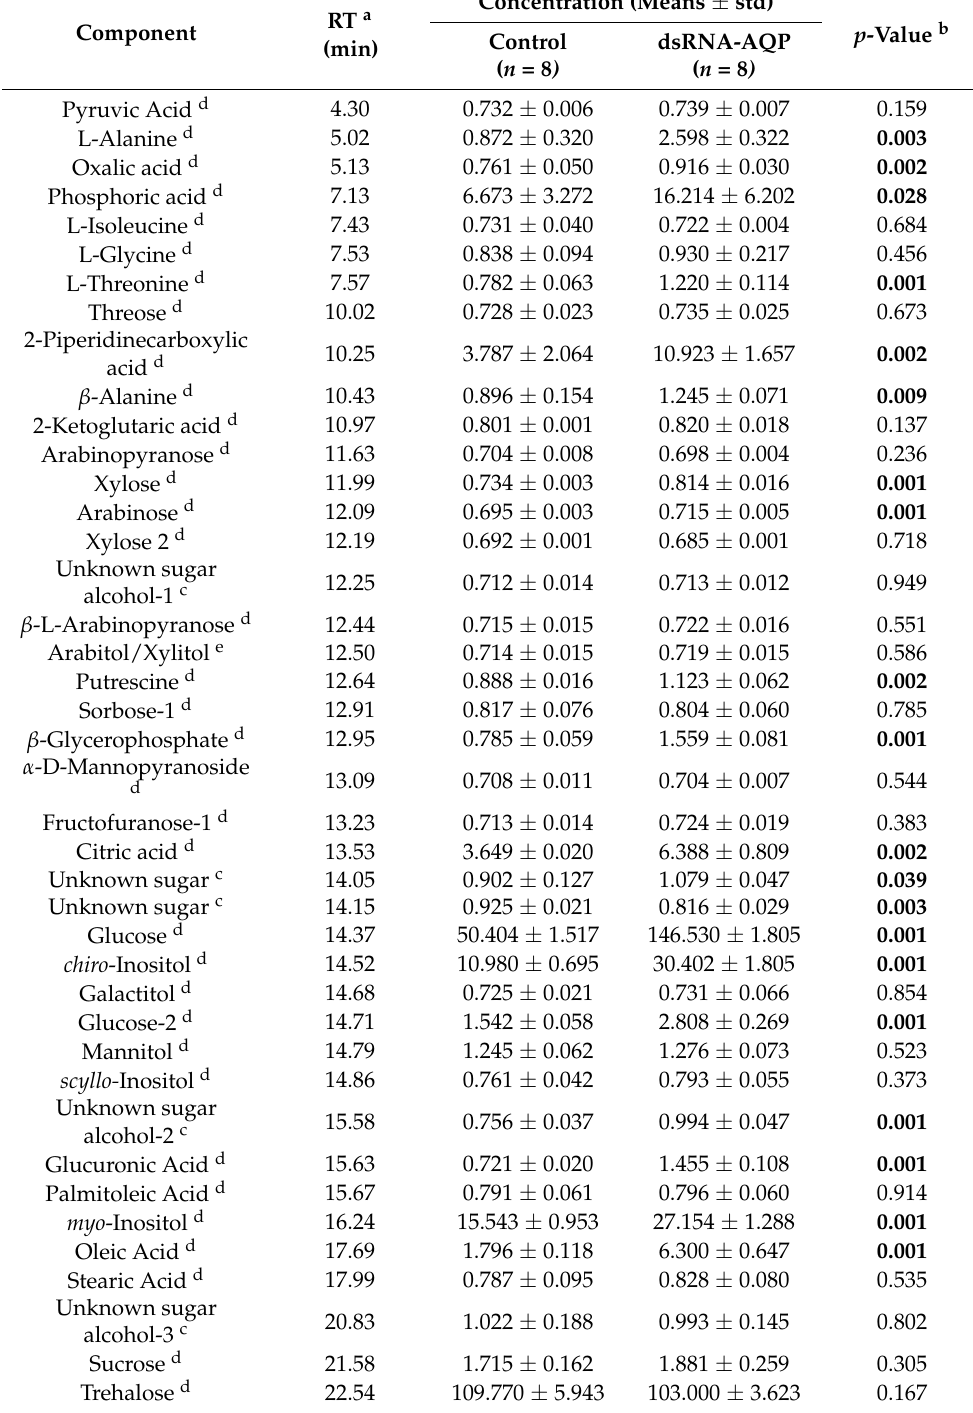
Table 2. Concentrations of different metabolic compounds (ng · insect − 1 ) detected in D. citri adults after derivatization with MSTFA using gas chromatography-mass spectrometry (GC-MS).